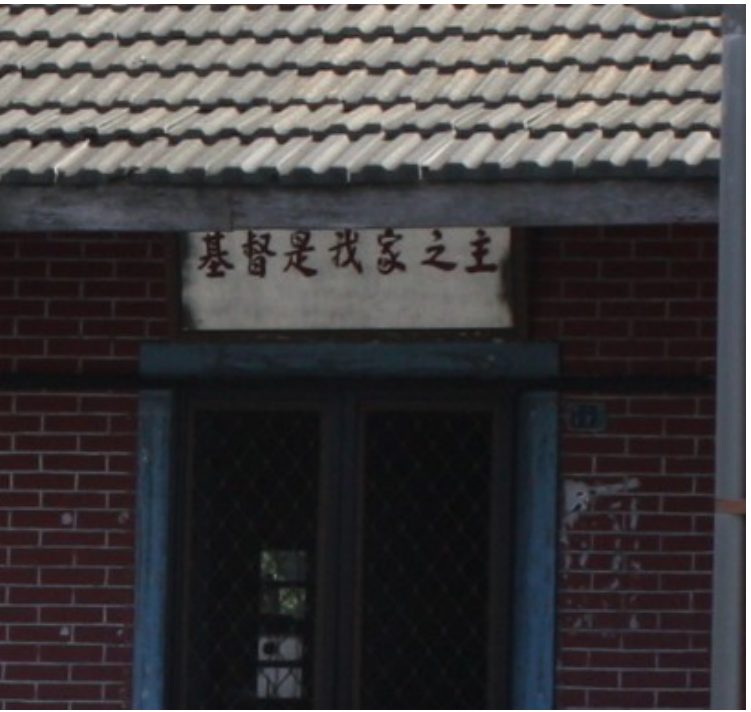
Figure 3. The characters in the lintel mean “Jesus is the Lord of my house” 基 督 是 我 家 之主